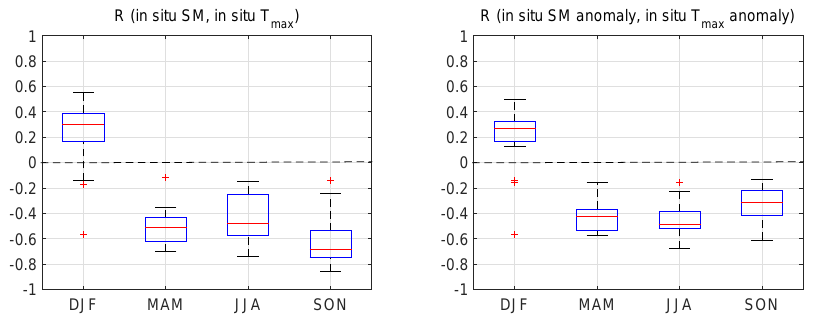
Figure 8. Correlation (R) of in situ SM at the SMOS morning passes and T max ( left ) and their anomalies ( right ) for each season: winter (December–January–February, DJF), spring (March–April–May, MAM), summer (June–July–August, JJA) and autumn (September–October–November, SON). Outliers are depicted with red crosses. Similar behavior is obtained with in situ SM acquired at the SMOS afternoon passes (not shown).